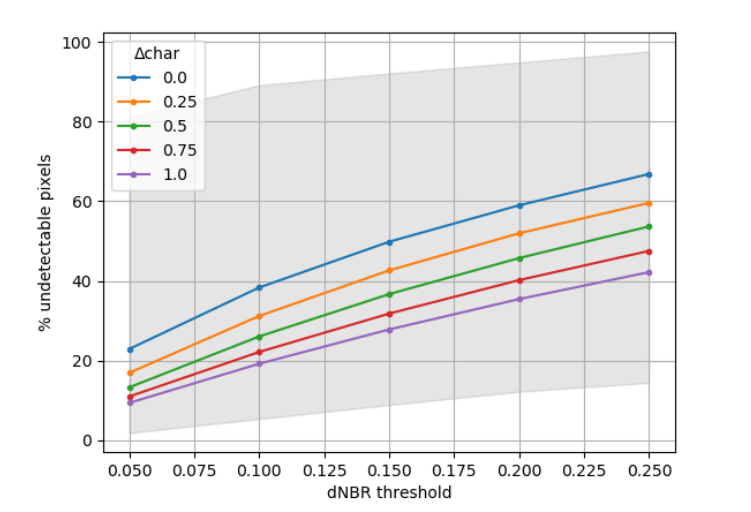
Figure 6. Percentage of undetectable burned pixels as a function of dNBR threshold and ∆ char parameter settings, park-wide for Landsat 8. Mean values are shown in colored lines, with total model result variation shown in gray.